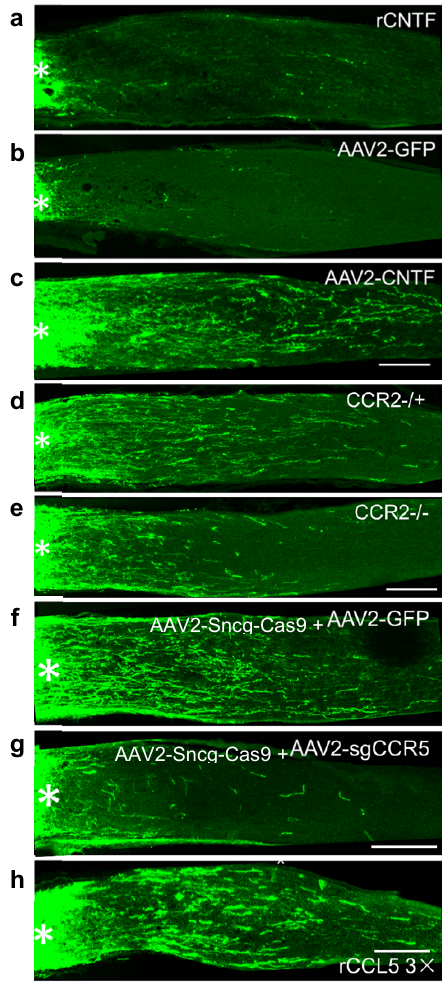
Figure 3. CNTF gene therapy induces optic nerve regeneration by augmenting inflammation and chemokine CCL5. ( a ) Recombinant CNTF protein (1 µg) does not induce appreciable regeneration. ( b , c ) Unlike a control adeno-associated protein expressing green fluorescent protein (AAV2-GFP), AAV2 expressing CNTF induces appreciable levels. ( d , e ) Whereas mice heterozygous for the chemokine 2 receptor (CCR2 +/ − ) regenerate axons in response to CNTF gene therapy ( d ), homozygous null mice show a strongly diminished response ( e ). ( f , g ) CRISPR-Cas9 mediated deletion of the chemokine 5 receptor CCR5. Mice received intraocular injection of an adeno-associated virus expressing Cas9 driven by the synuclein-g promoter plus a second virus expressing either GFP (( f ), control) or a small guide RNA directed to CCR5 ( g ), which nearly eliminated regeneration induced by CNTF gene therapy. ( h ) Recombinant CCL5 induces nearly as much regeneration as CNTF gene therapy. Asterisks indicate lesion site [22].